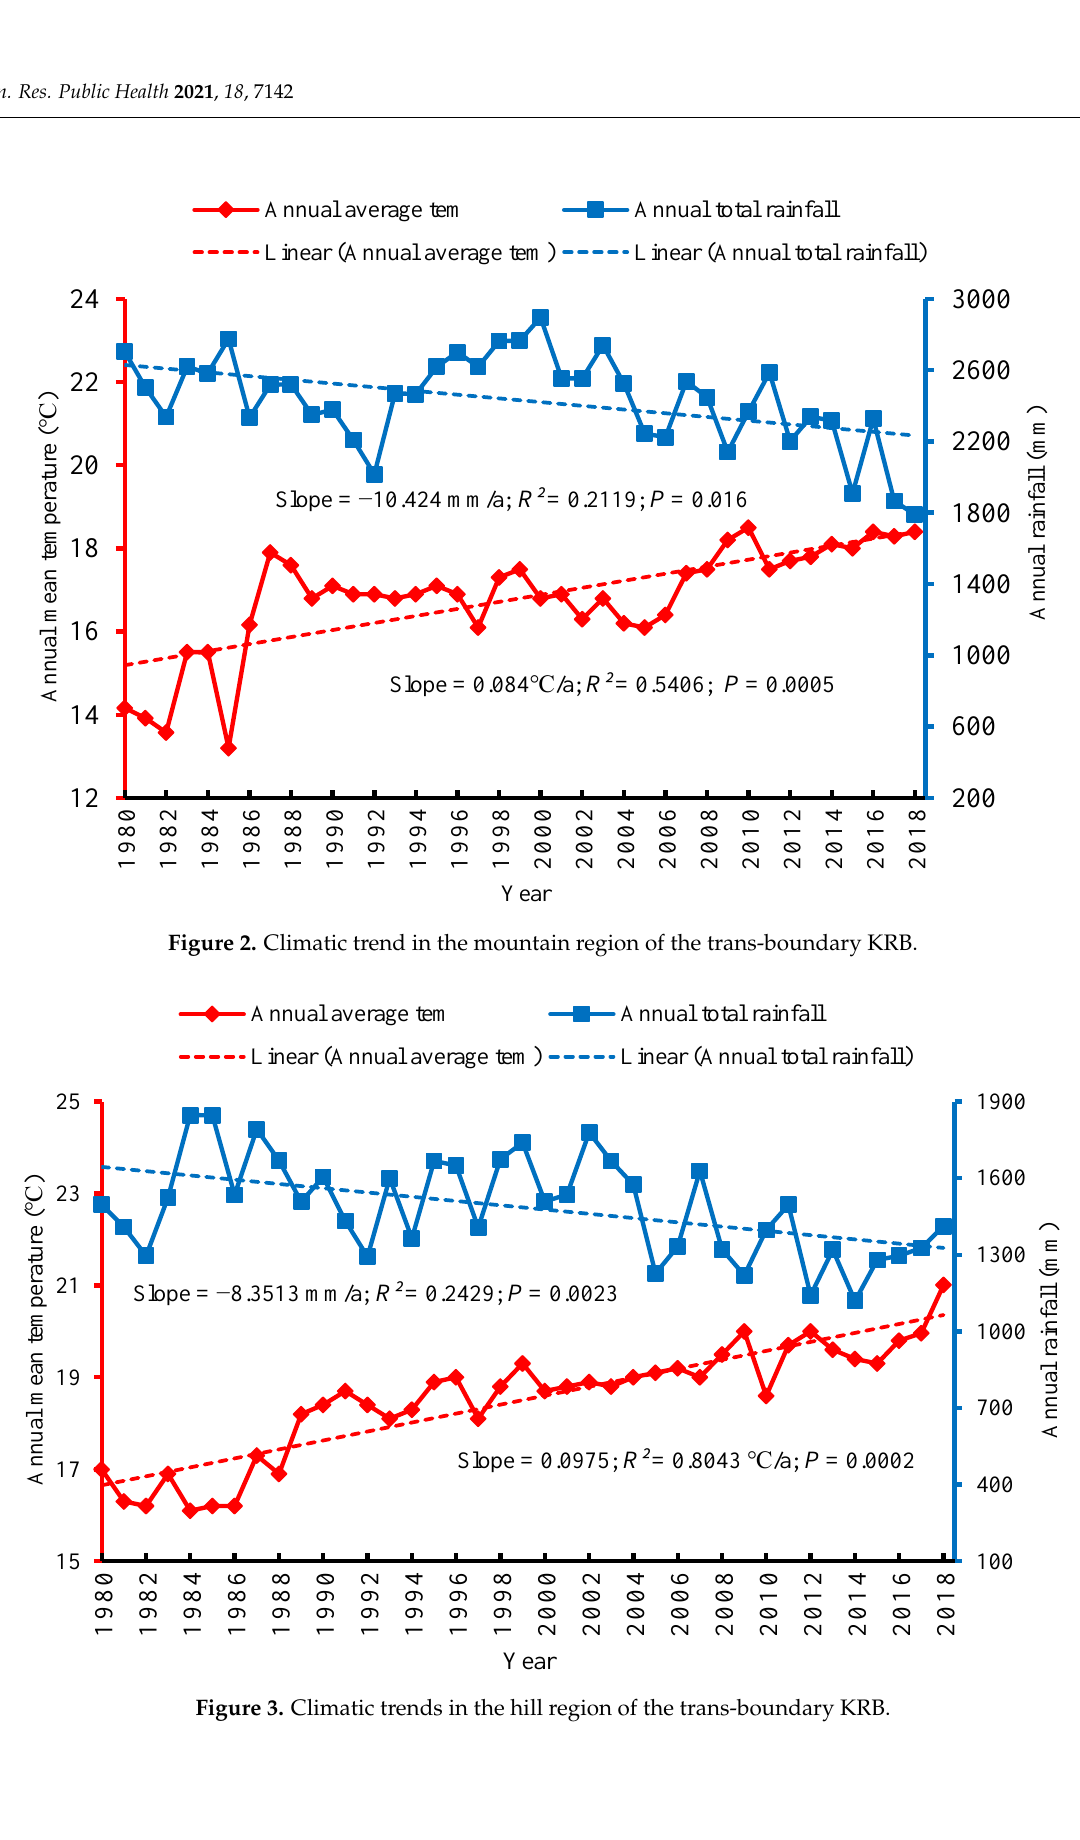
Figure 4. Climatic trend in the Tarai region of the trans-boundary KRB. Slope = 0.0187; R² = 0.2086 ℃/a; P = 0.0206 Slope = −6.7334 mm/a; R² = 0.0754; P = 0.0498